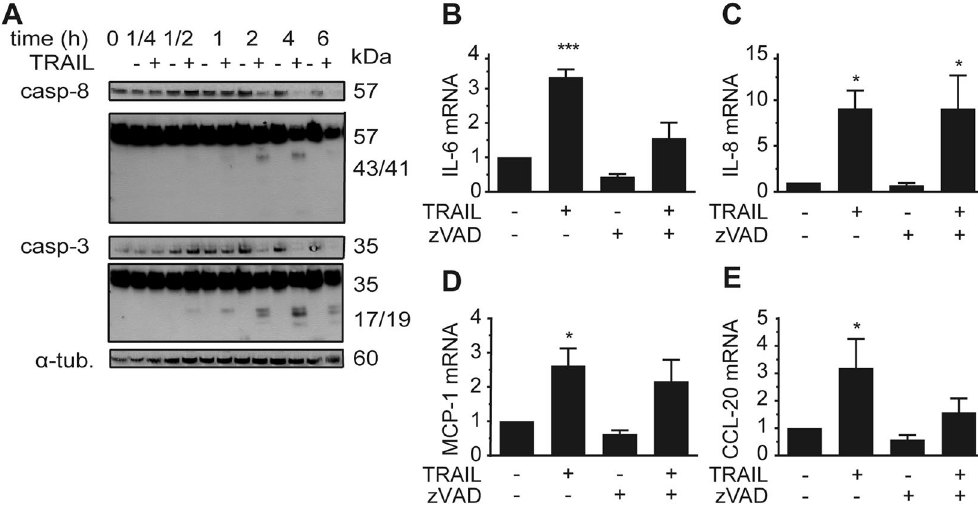
Figure 4. TRAIL triggers caspase activation. ( A ) SGBS adipocytes on day 14 of adipogenic differentiation were treated with TRAIL (30 ng/ml) or vehicle and protein was isolated at different timepoints (1/4, 1/2, 1, 2 and 6 hours). Cleavage of caspase-8 and caspase-3 was analyzed by Western blot. α -tubulin was used as a loading control. One representative blot out of three performed experiments is presented. ( B–E ) SGBS adipocytes on day 14 of adipogenic differentiation were treated with TRAIL (30 ng/ml) or vehicle in the absence or presence of the pan-caspase inhibitor zVAD.fmk (20 μ M). After 6 hours, IL-6 ( B ), IL-8 ( C ), MCP-1 ( D ) and CCL-20 ( E ) expression was analyzed by qPCR. The mRNA levels were normalized to HPRT. Depicted are the means and SEM of 3 independent experiments. One-way ANOVA and Dunnett’s multiple comparison were used to test for statistical significance. * p < 0.05, ** p < 0.01, *** p <